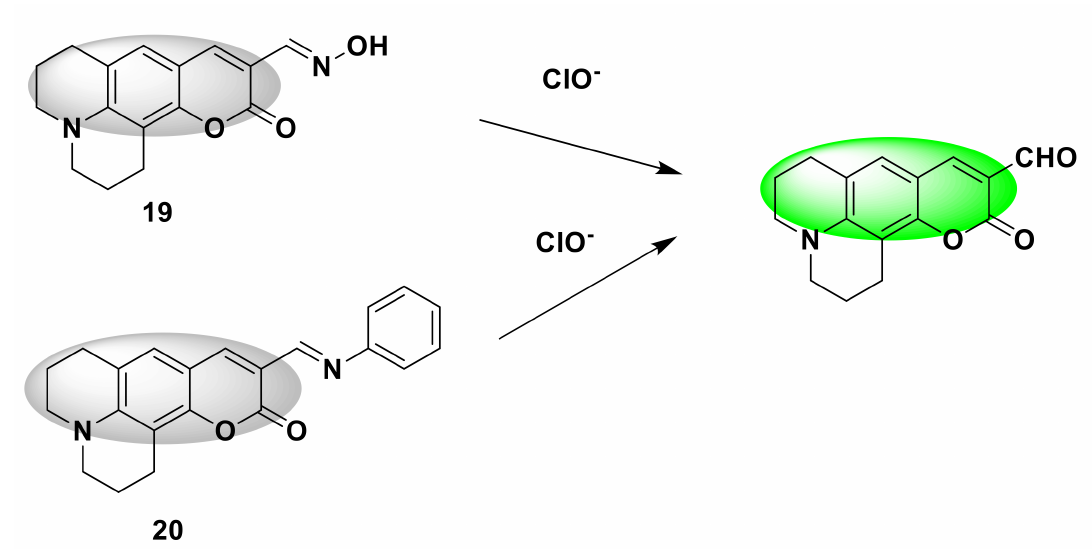
Figure 20. The reactions of probes 19, 20 and ClO −